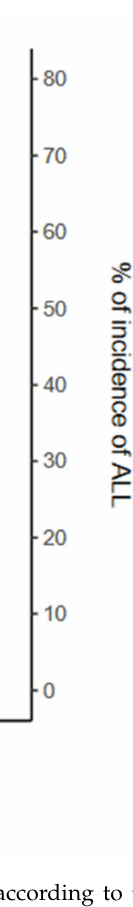
Figure 1. Incidence of ALL per 100,000 inhabitants by age (2014–2018) according to the SEER database